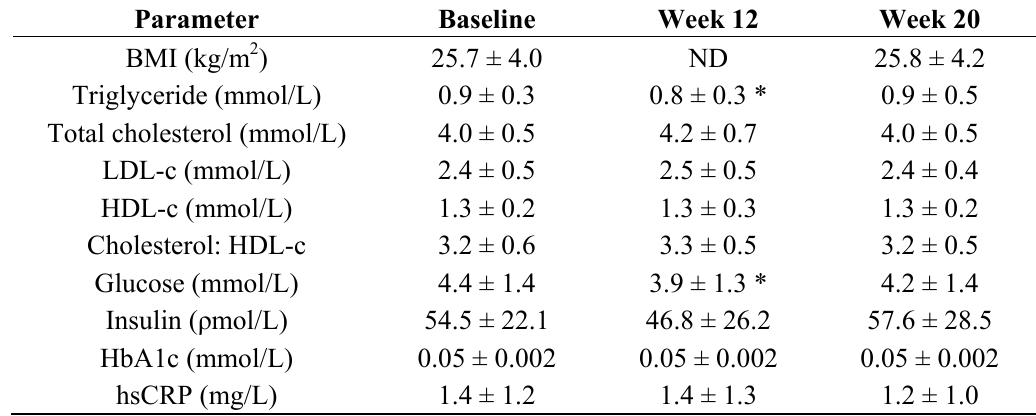
Table 1. Participant characteristics. Average anthropometric and clinical measures are listed at baseline, week 12, and week 20 for study participants ( n = 12). Values are indicated as mean ± SD. * Indicates p < 0.05 compared to baseline. ND, not